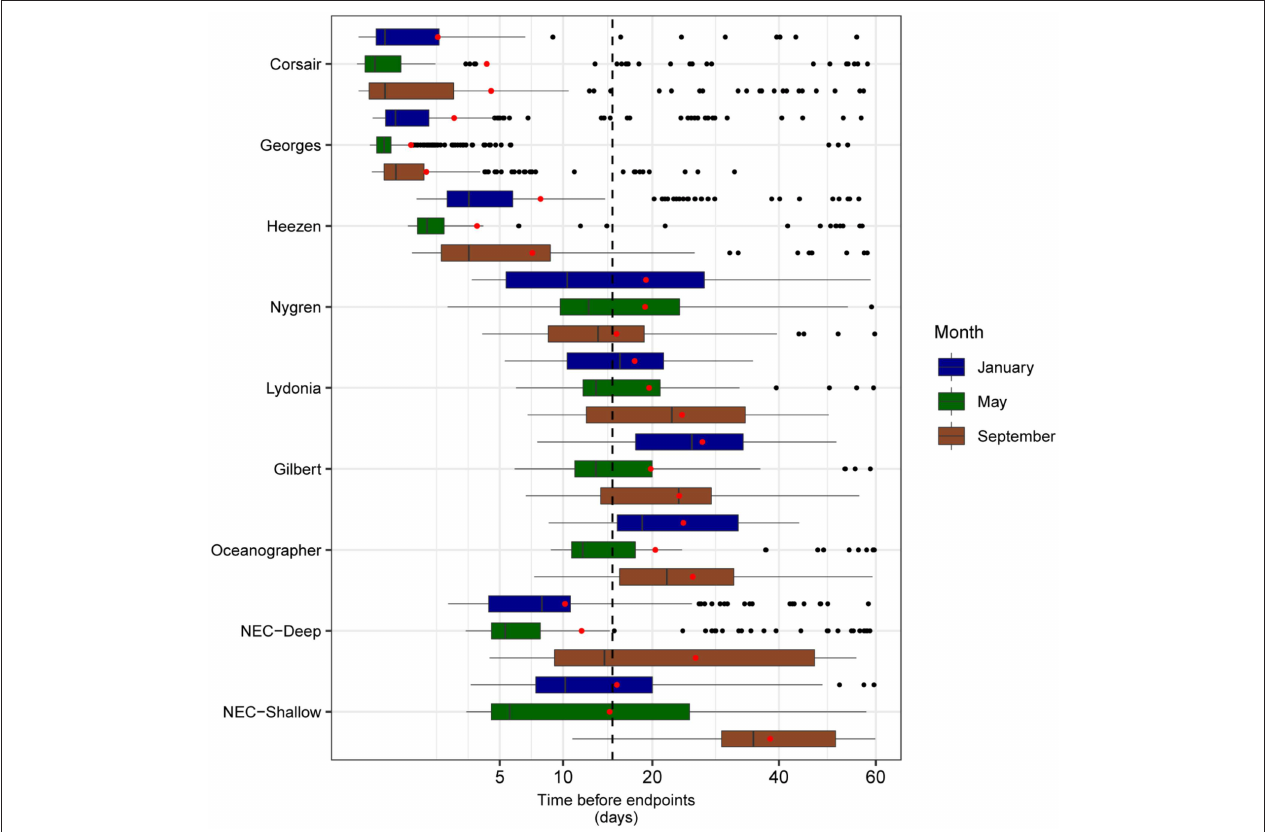
FIGURE 10 | Boxplots of mean minimum transit time calculated from all tracks overlapping each zone of interest, segregated by month (sample sizes for the zone-month combinations are given in Table 4). Mean transit times for each month-zone combination (red diamonds) and overall average (black dashed line) are also